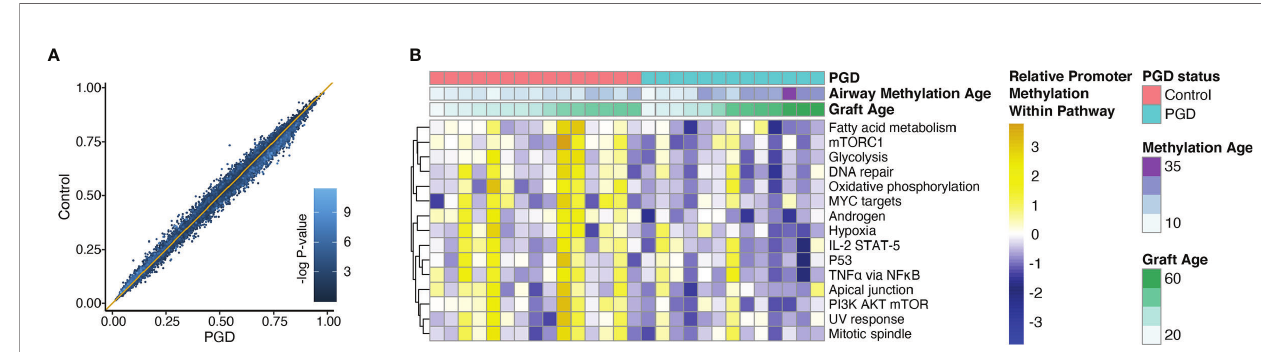
FIGURE 4 | Promoters within speci fi c gene sets were hypomethylated relative to non-PGD subjects. Average methylation values were determined for CpG sites in gene promoter regions. Average values for PGD subjects (x-axis) are plotted against average values non-PGD control subjects (y-axis) for each CpG site. There were no differentially methylated promoters after adjustment for multiple comparisons. Each dot color corresponds to the -log of the unadjusted p-value for each site (A) . Promoter methylation within the MSigDB Hallmark gene sets were compared for between PGD and control subjects. The top 15 most differentially methylated pathways are shown, all with a false discovery-adjusted P-value of <0.01 by Kolmogorov – Smirnov test (B) .